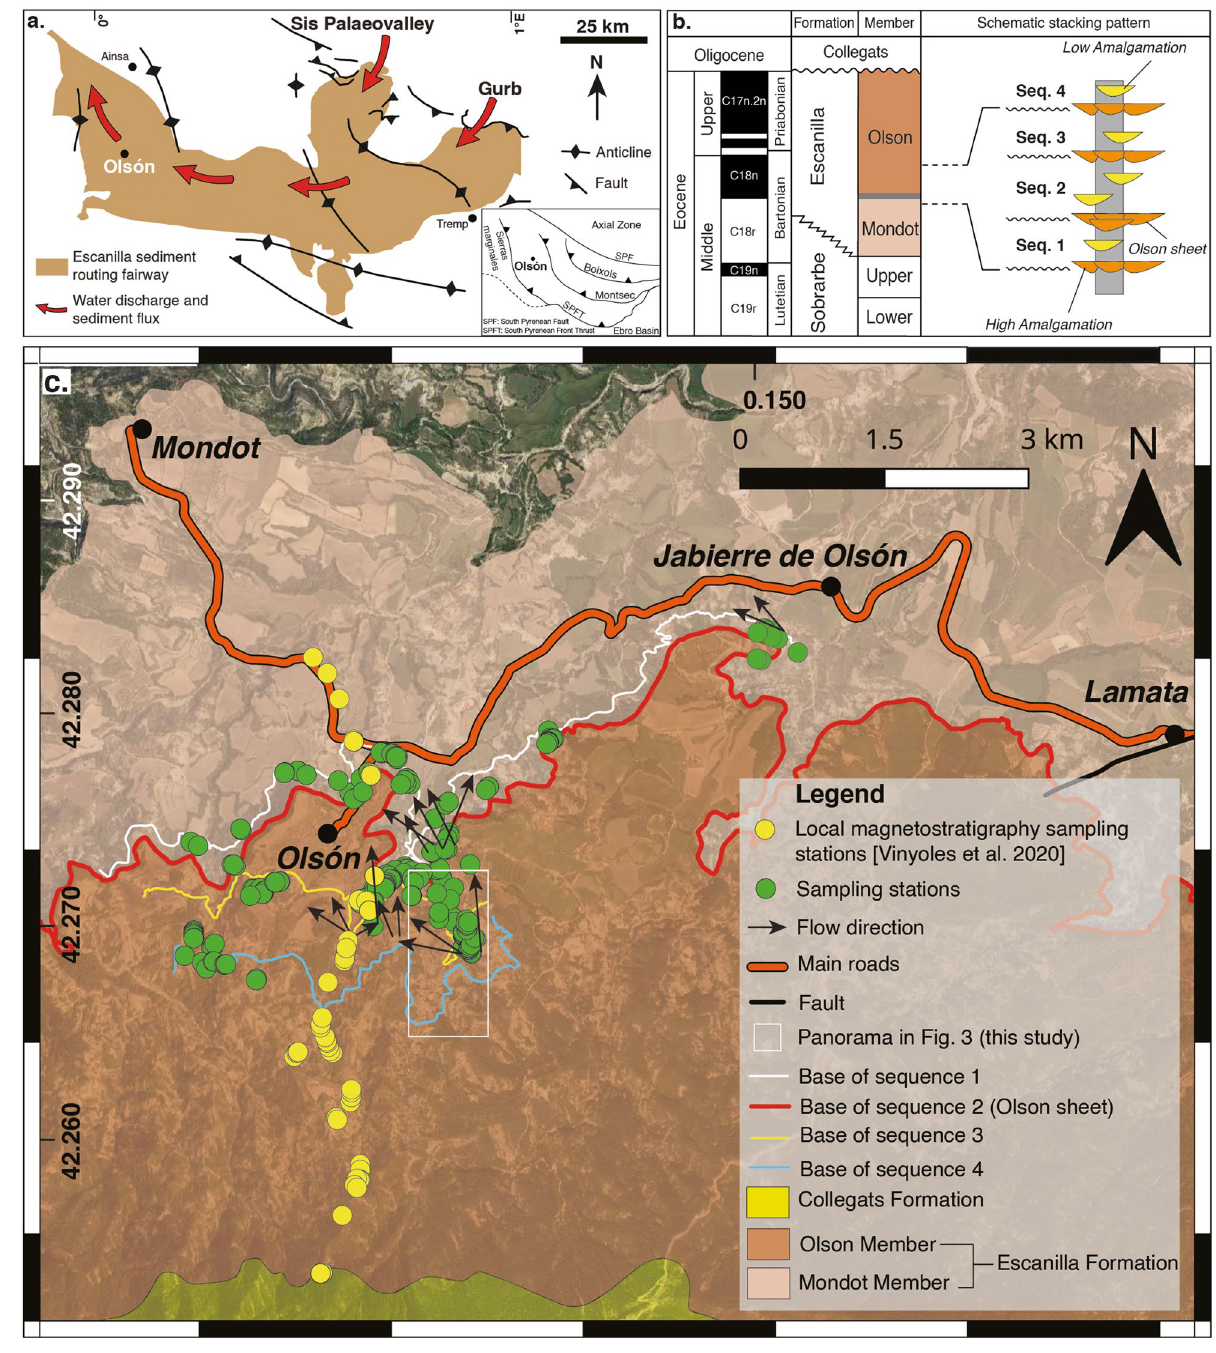
Figure 2. Geological setting of the Escanilla sediment routing system and the Escanilla Formation at Olson. ( a ) Geological setting of the South-Pyrenean Foreland basin containing the Escanilla sediment routing fairway. Red arrows mark the sediment transport direction of the Escanilla system from the source regions of Sis and Gurb ( b ) Lithostratigraphic framework 40,41 of the Escanilla Formation at Olson consists of two main Members – the Mondot and Olson Members with the ‘Olson sheet’ lying at the transition between the two Members. Also displayed is the magnetostratigraphic correlation 42 and the schematic stacking pattern along the studied section. It is noteworthy that the thickest normal magnetozone represents Chron C18n, which includes C18n.1n + C18n.1r + C18.2n (the very short C18n.1r is missing) ( c ). Geological map of the southern Ainsa basin encompassing the Escanilla Formation around the village of Olson where the study area lies. Sampling stations are displayed along with flow directions with respect to the sampled sequences. The ‘Olson sheet’ is marked in red as a basin wide, laterally extensive amalgamated channel body lying in-between the Mondot and Olson Members of the Escanilla Formation. A Google Earth panel with locations of sampling stations has been provided in the supplementary material as Figure S1. This map was prepared using QGIS Desktop 3.22.8 (https:// qgis. org/ en/